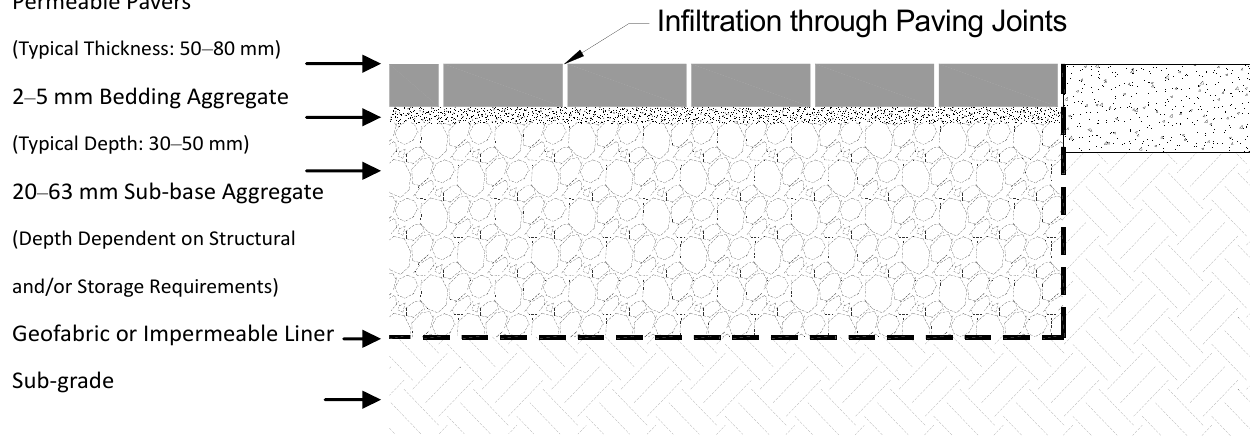
Figure 1. Typical permeable pavement